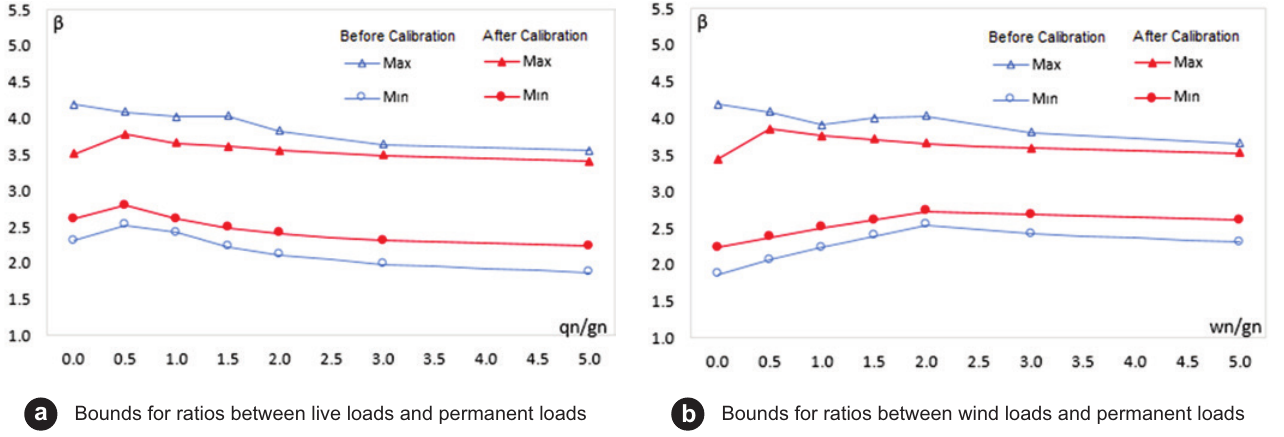
a Bounds for ratios between live loads and permanent loads b Bounds for ratios between wind loads and permanent loads